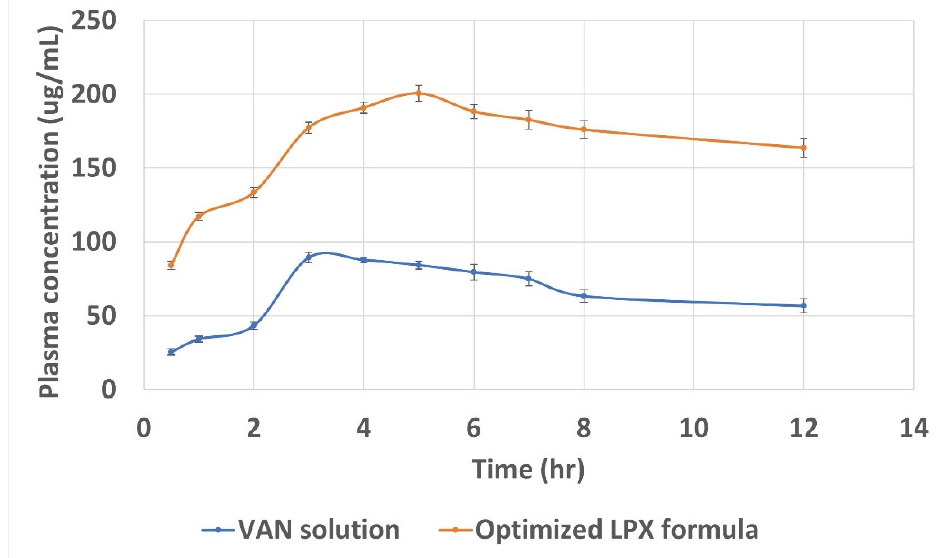
Figure 9. Mean plasma concentration-time curve of VAN following oral administration of the optimized LPX formula and VAN aqueous solution. Abbreviation: VAN, vancomycin hydrochloride; LPX, leciplex.